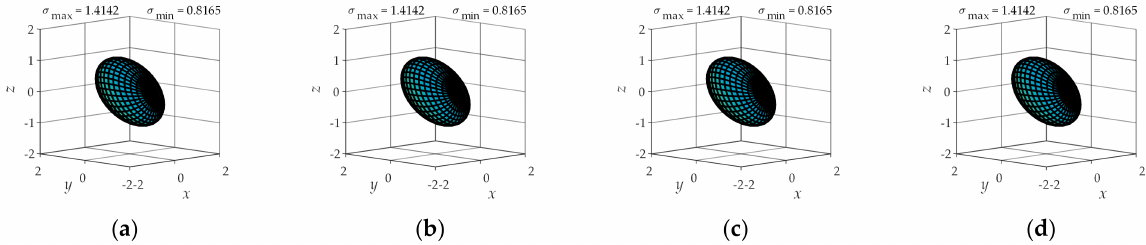
Figure 20. Manipulability ellipsoid of 2 P a 1 P 3 R a in the horizontal plane. ( a ) α = 30 ◦ ; ( b ) α = 60 ◦ ; ( c ) α = 90 ◦ ; ( d ) α = 120 ◦